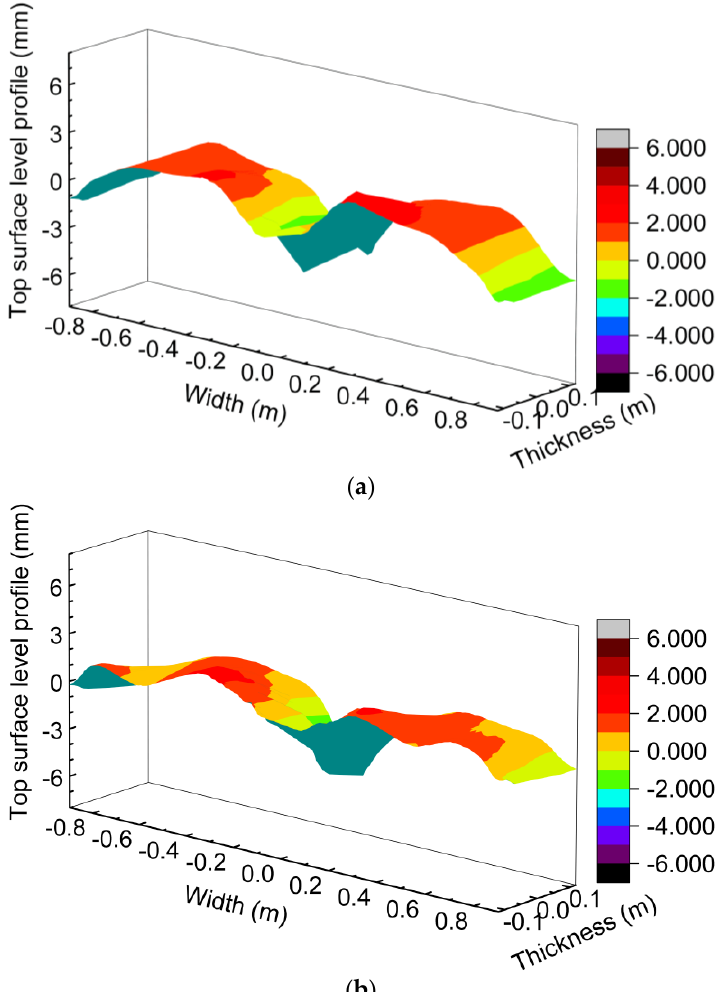
Figure 8. Top surface level profile of mold under different casting speeds of ( a ) 1.1 m/min, ( b ) 1.2 m/min.